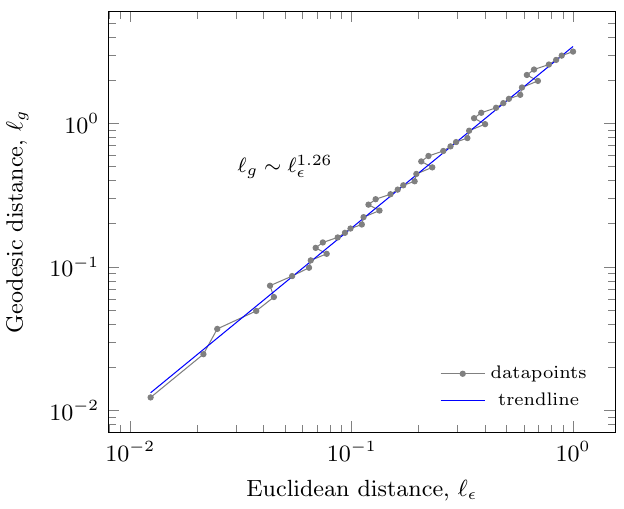
Figure 2. Relation between (cid:96) (cid:101) and (cid:96) g for the standard von Koch